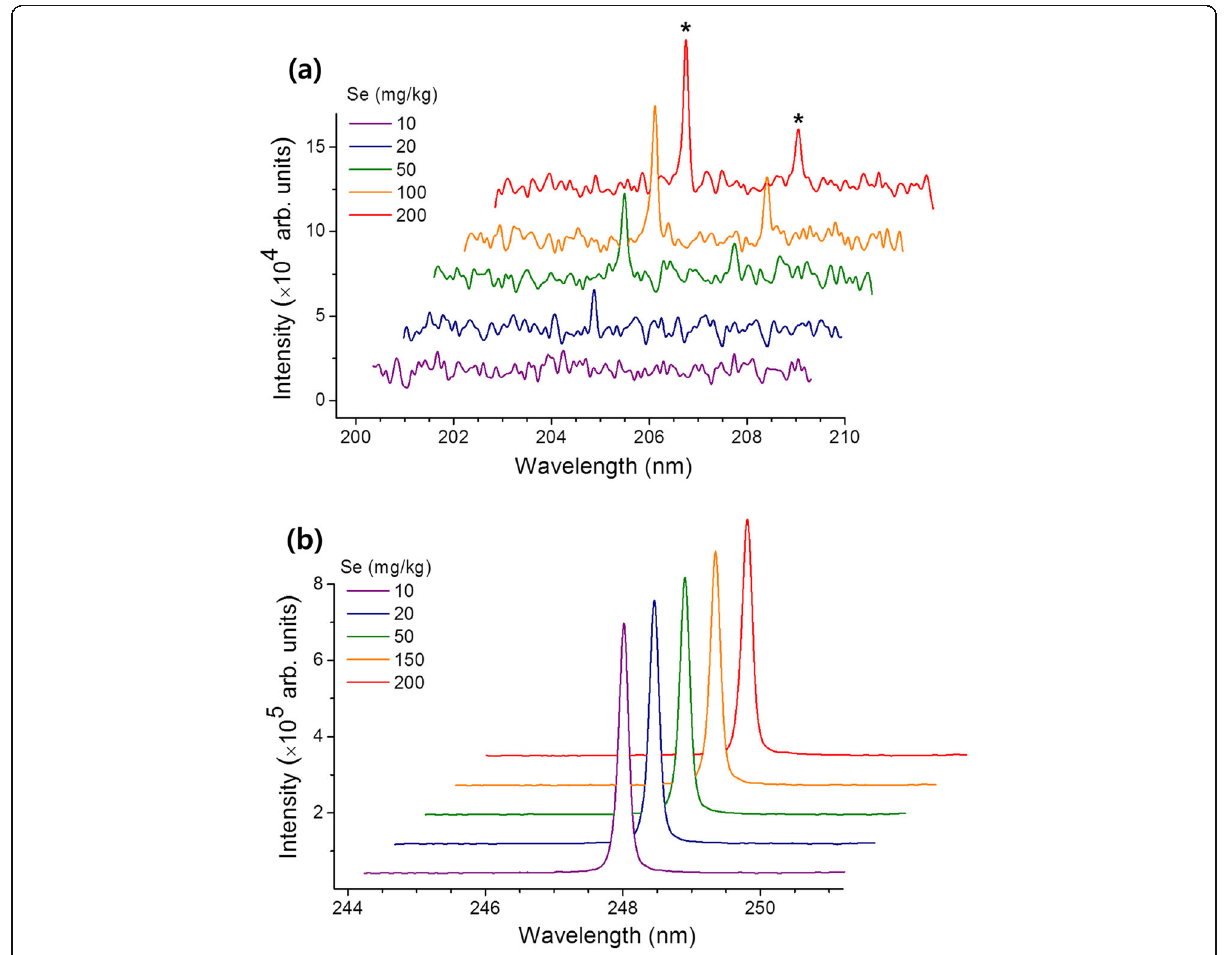
Fig. 3 LIBS spectra of the LIBS calibration standards with five different Se (VI) concentrations (10, 20, 50, 150, and 200 mg/kg) in the wavelength regions where the a Se (I) and b C (I) emission lines were observed. In ( a ), the two peaks denoted by “ * ” are the Se (I) emission lines at 203.99 and 206.28 nm. The C (I) lines at 247.86 nm, shown in ( b ), originated from the membrane filter